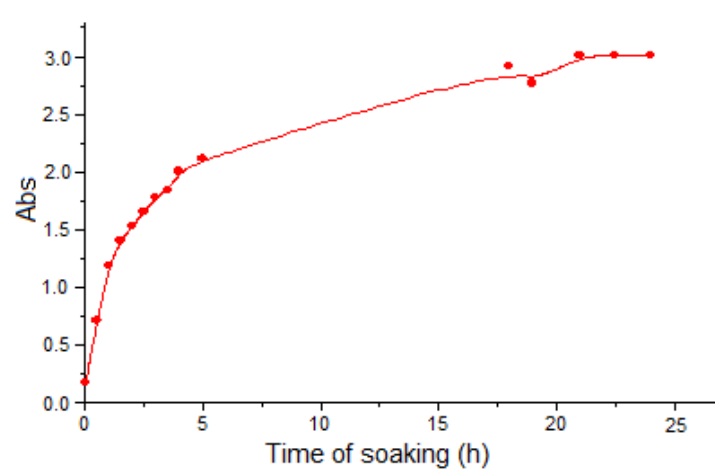
FIGURE 2 - Soaking time Vs. UV absorbance of the released CAF from AY-IPUF